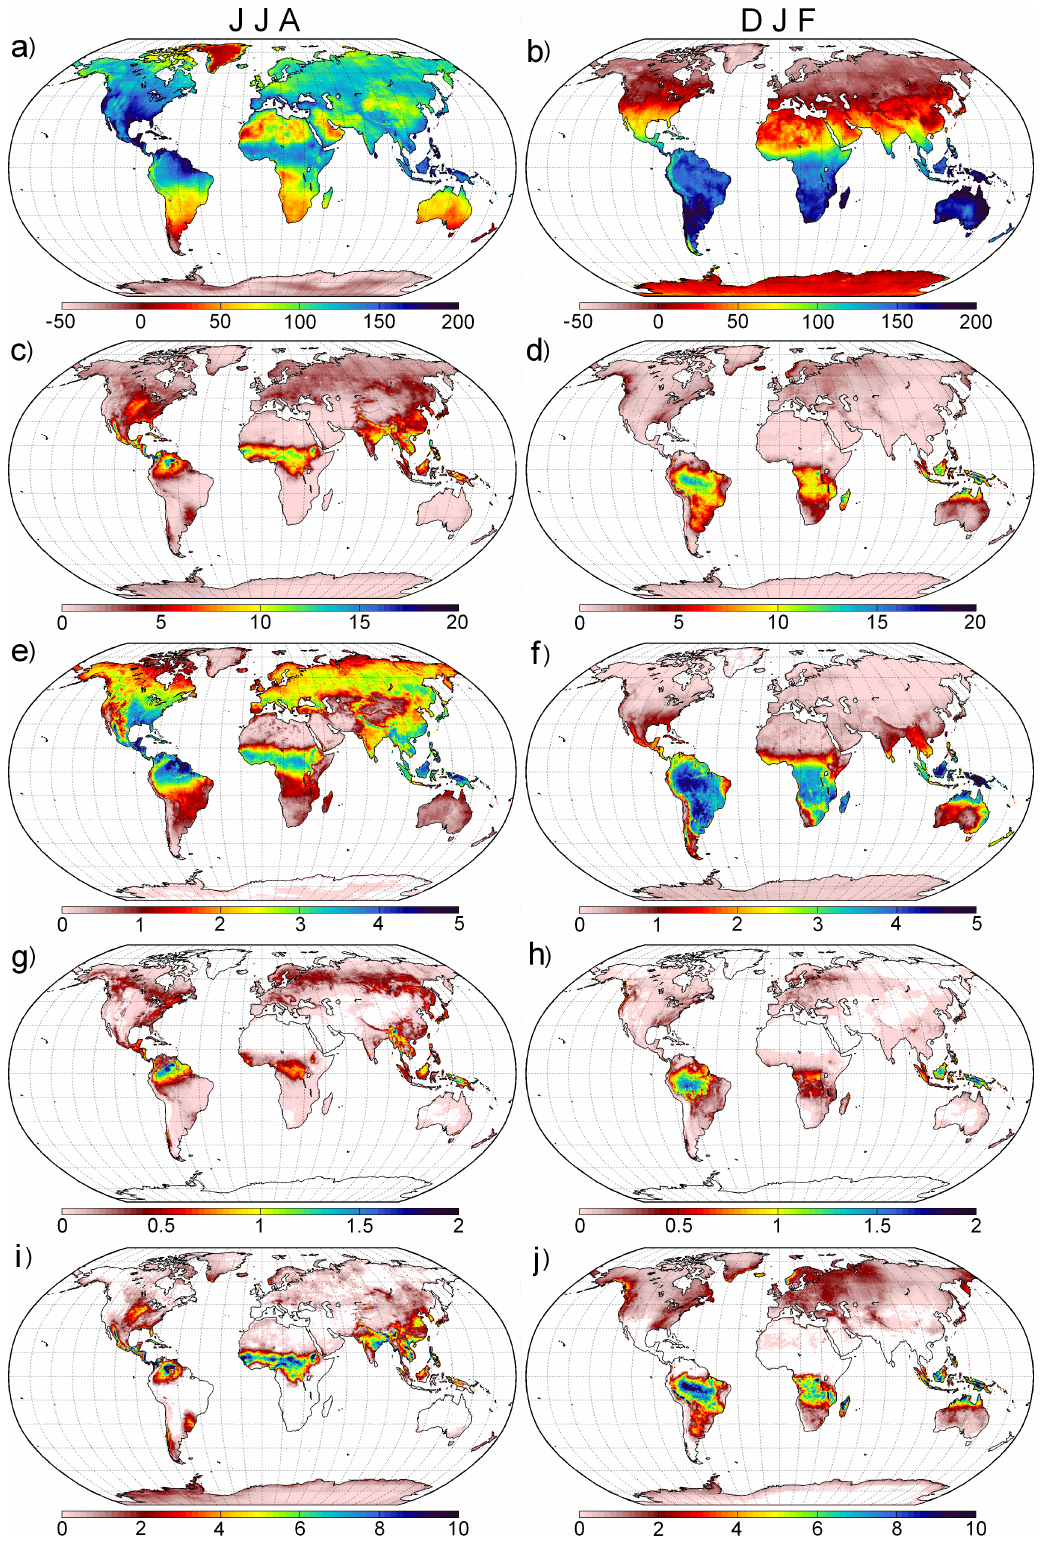
Fig. 7. Average fluxes for the period 2003–2007 separately presented for JJA (left panel) and DJF (right panel): (a) and (b) show the distribution of R n , (c) and (d) represent P , (e) and (f) are E , (g) and (h) are I , and (i) and (j) present the estimated distribution of P − E . Units are mmday − 1 except for R n which is presented in Wm − 2